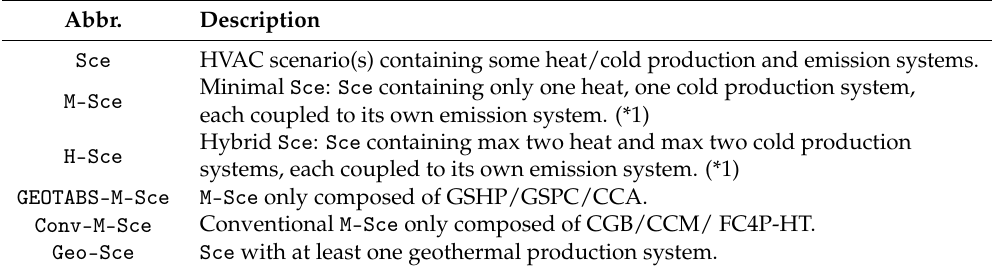
Table 5. Description of the abbreviations used in Section 6. When the abbreviation is followed by a star (*), it indicates that the scenario is cost optimal compared to the scenarios of the same type.